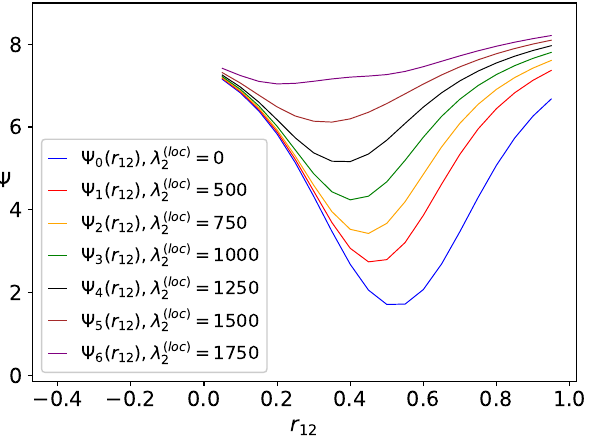
Figure 18. Mean backlog Ψ during ∆ as a function of routing probabilities r 12 , r 13 = 1 − r 12 , each curve corresponds to a different flow coming from Host 4 to S